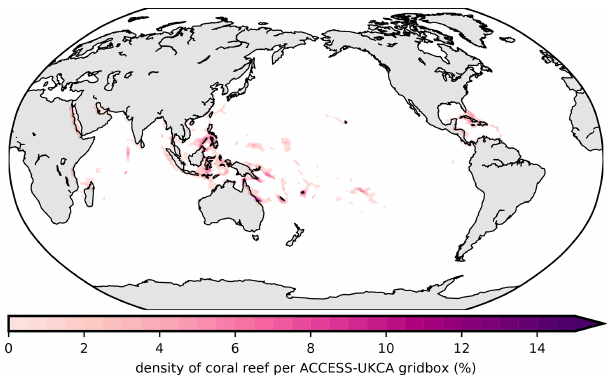
Figure 2. The areal fraction of each ACCESS-UKCA grid box cov- ered by warm water coral reefs as indicated by UNEP-WCMC et al.